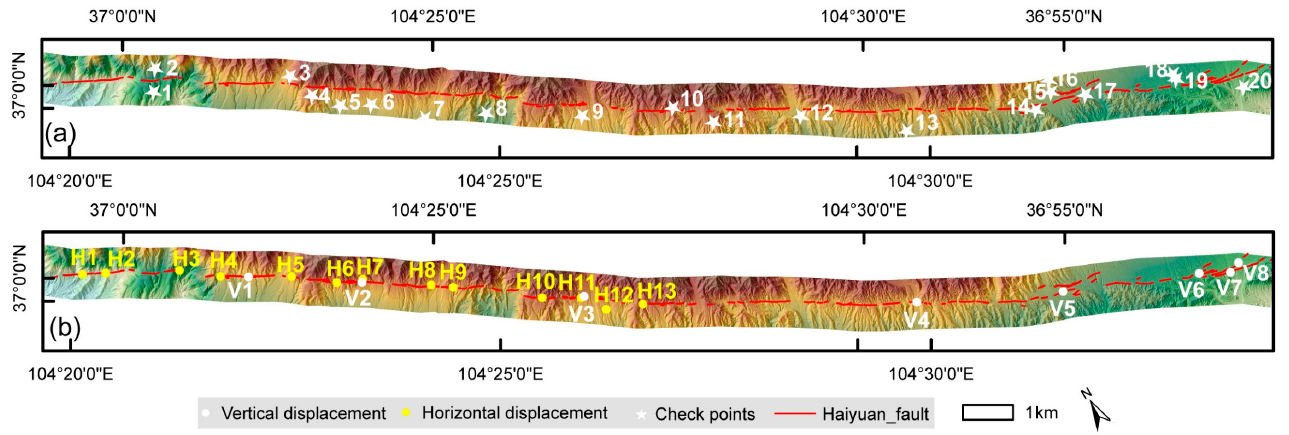
Figure 2. The distribution of ( a ) the checkpoints and ( b ) the positions for measurement of the vertical and horizontal offset. and horizontal